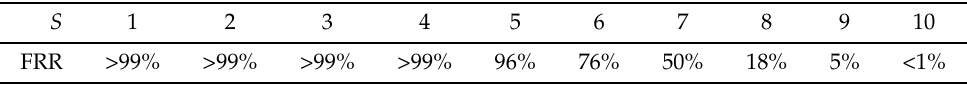
Table 3. Feasible reconstruction rates for an SNR of 40 dB.